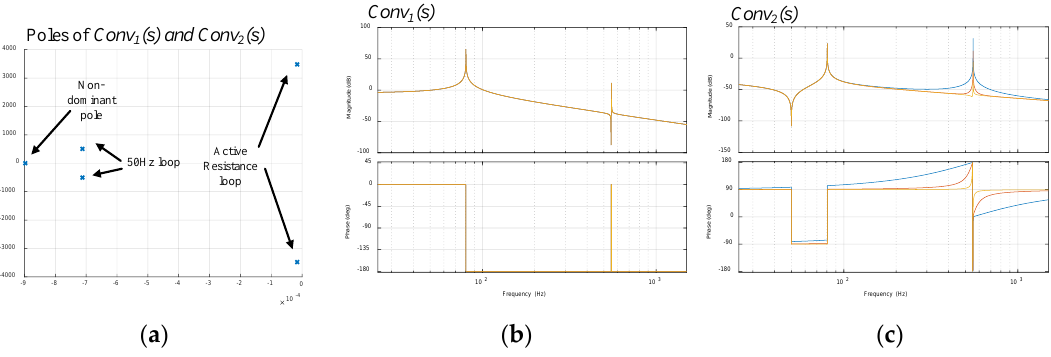
Figure 8. Poles and Bode plots of Conv 1 ( s ) and Conv 2 ( s ) at different active resistance values. ( a ) Poles of Conv 1 ( s ) and Conv 2 ( s ), ( b ) Bode plot of Conv 1 ( s ), ( c ) Bode plot of Conv 2 ( s ) (blue: R v 1 = 7.562 Ω , red: R v 1 = 75.62 Ω , orange: R v 1 = 756.2 Ω ).